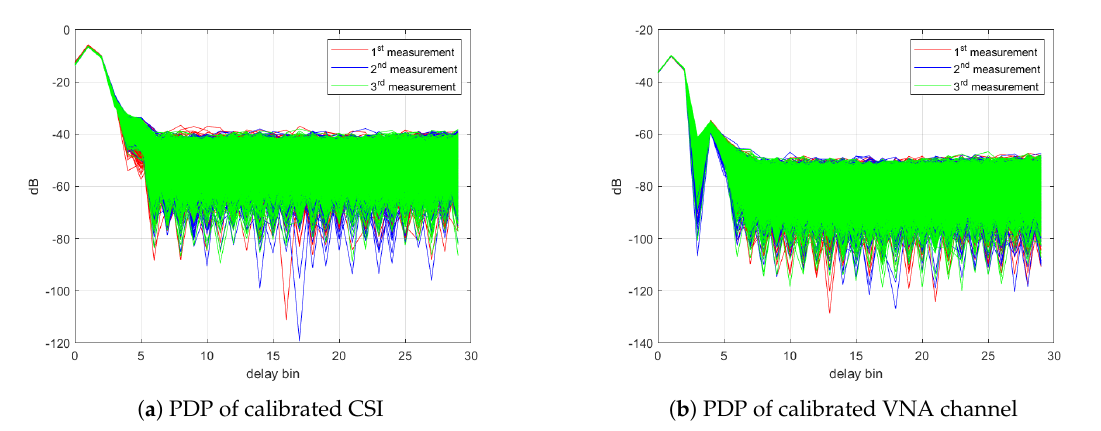
Figure 10. Power delay profile of ( a ) calibrated CSI and ( b ) calibrated VNA